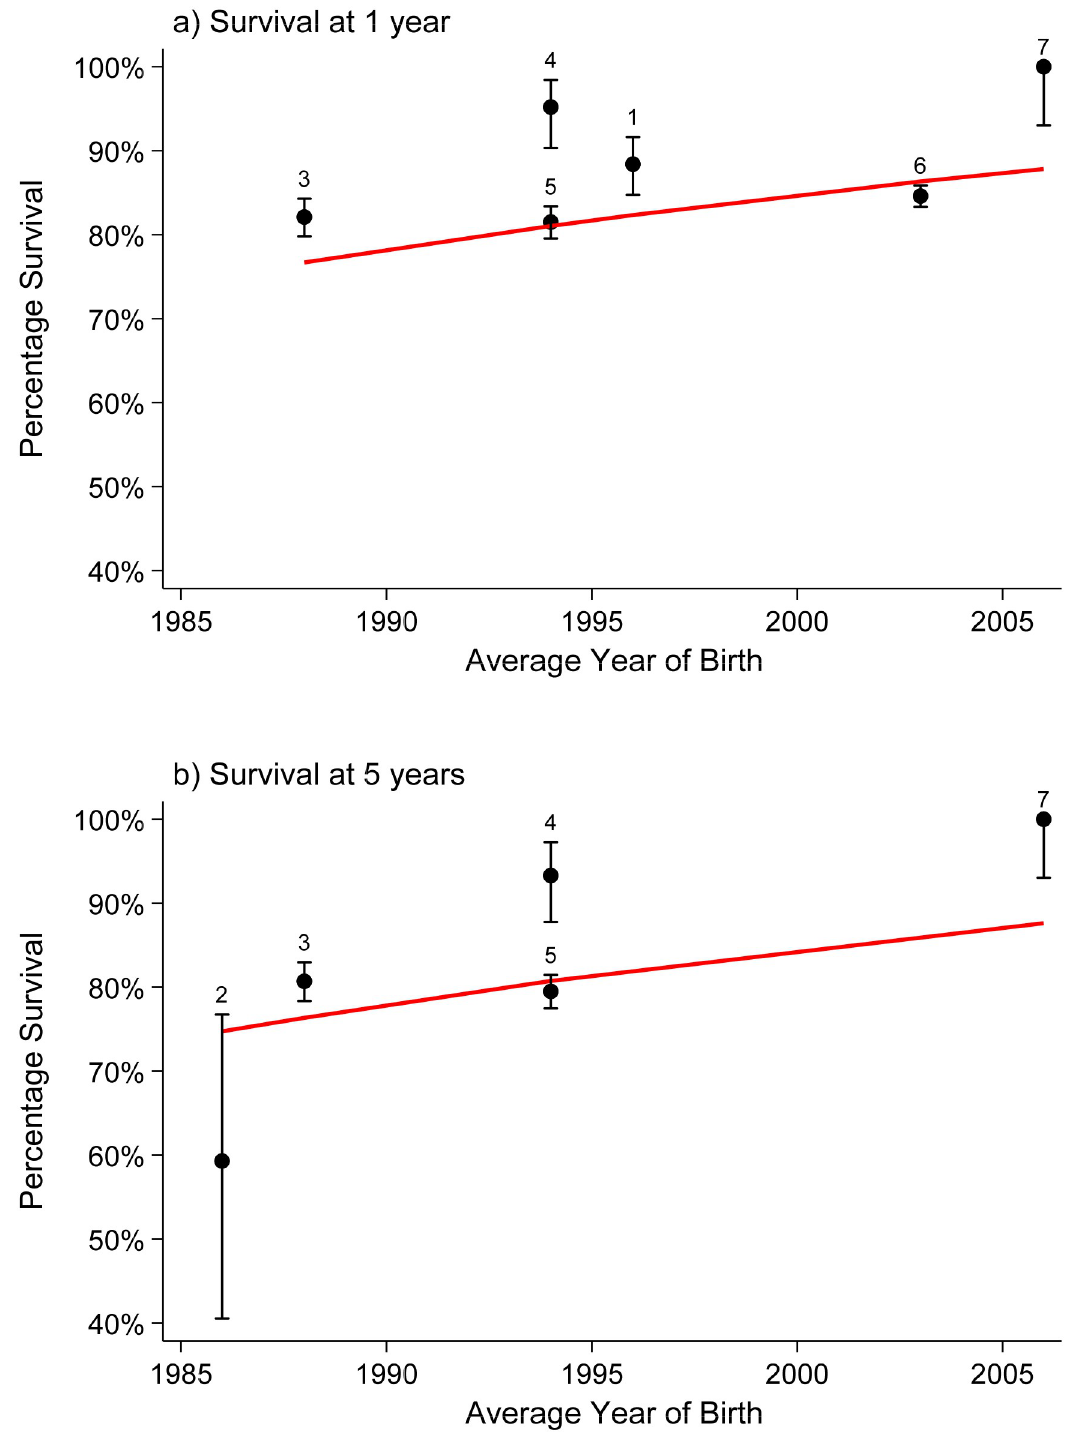
Fig 3. Survival estimates (with 95% confidence intervals) of children with oesophageal atresia at 1 (a) and 5 (b) years of age over time (7 studies). The numbers at survival points indicate the included study: 1 –Cassina, 2016, Northeast Italy; 2 –Garne, 2002, Funen, Denmark; 3 –Oddsberg, 2012, Sweden; 4 –Tennant, 2010, Northern England; 5 –Wang, 2011 USA; 6 –Wang, 2015, USA; 7 –Schneuer, 2019, New South Wales, Australia.